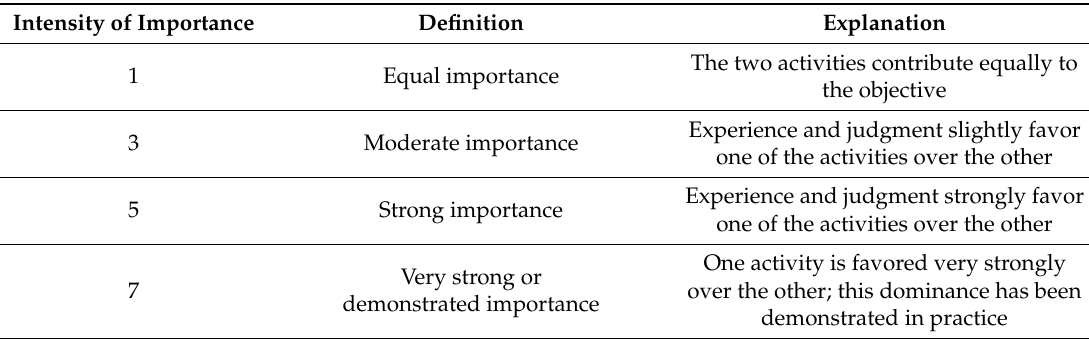
Table 1. The fundamental scale of absolute